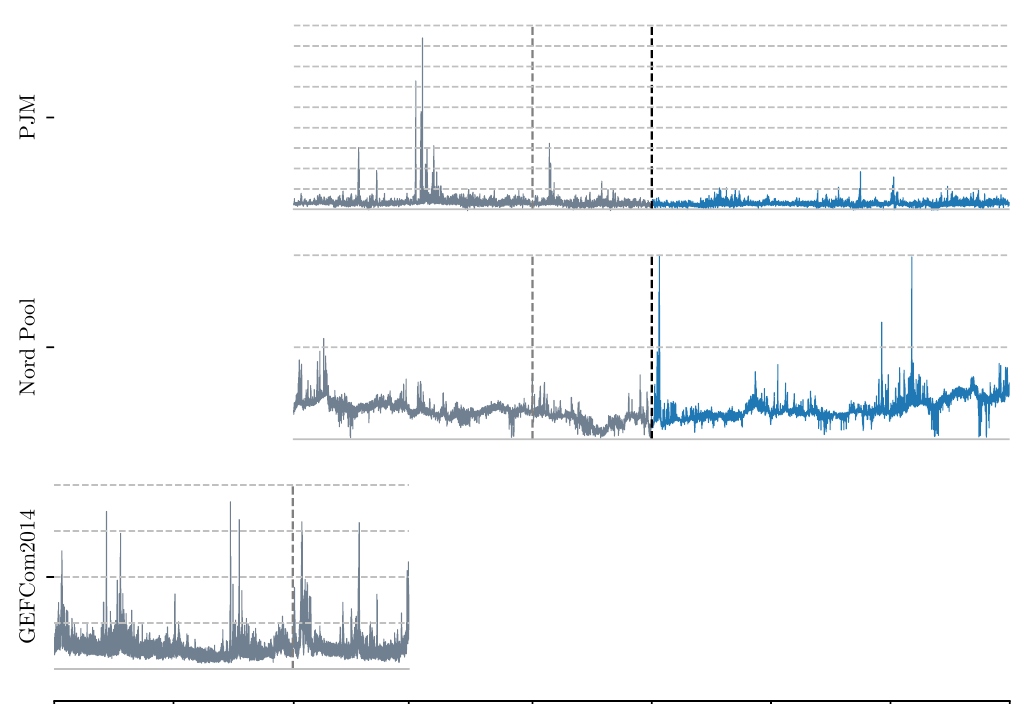
Figure 1. Timeline of the datasets considered in the study. The periods used for hyper-parameter calibration are drawn in gray, whereas the out-of-sample test periods are in